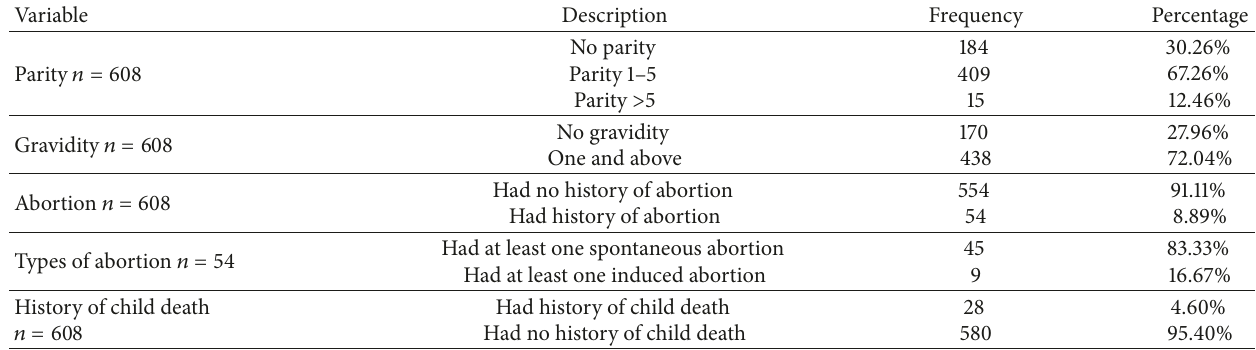
Table 2: Number of respondents by obstetric history and time of first ANC, Shebedino district in 2015.